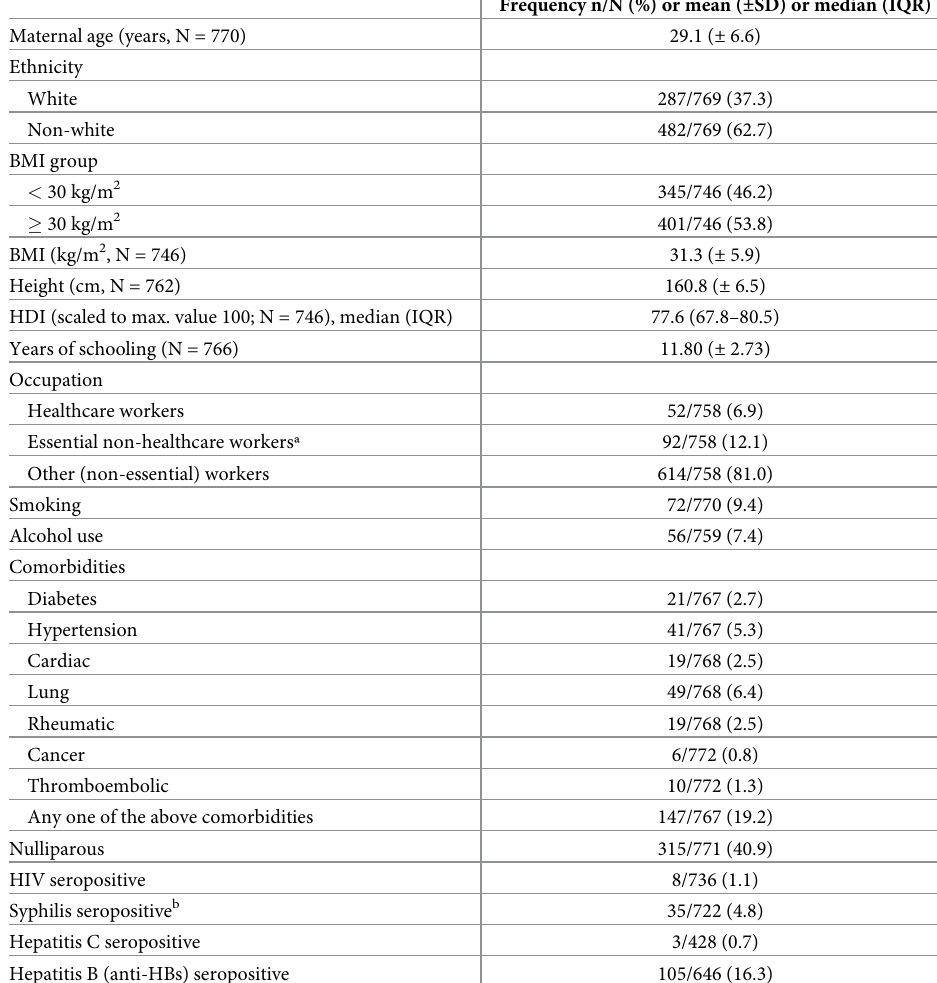
Table 1. Population characteristics. (N = 772